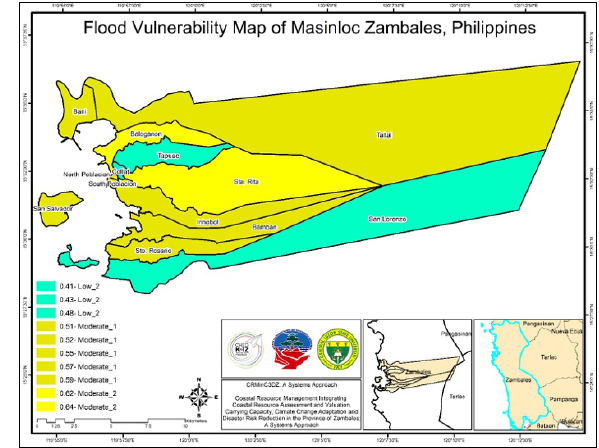
Figure 1. Flood vulnerability map of Masinloc, Zambales, Philippines